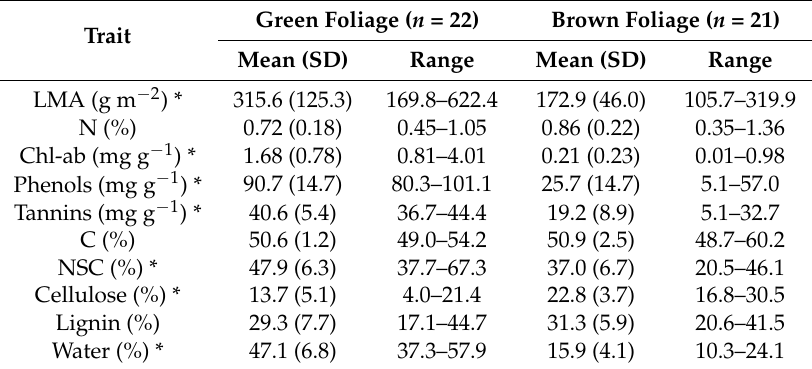
Table 1. Foliar traits for live green and ROD-infected brown foliage in ʻ ō hi ʻ a canopies. For each trait, an asterisk (*) indicate significant differences between group means ( t -tests; p < 0.01). Phenols and tannins were measured in only seven green leaf samples.